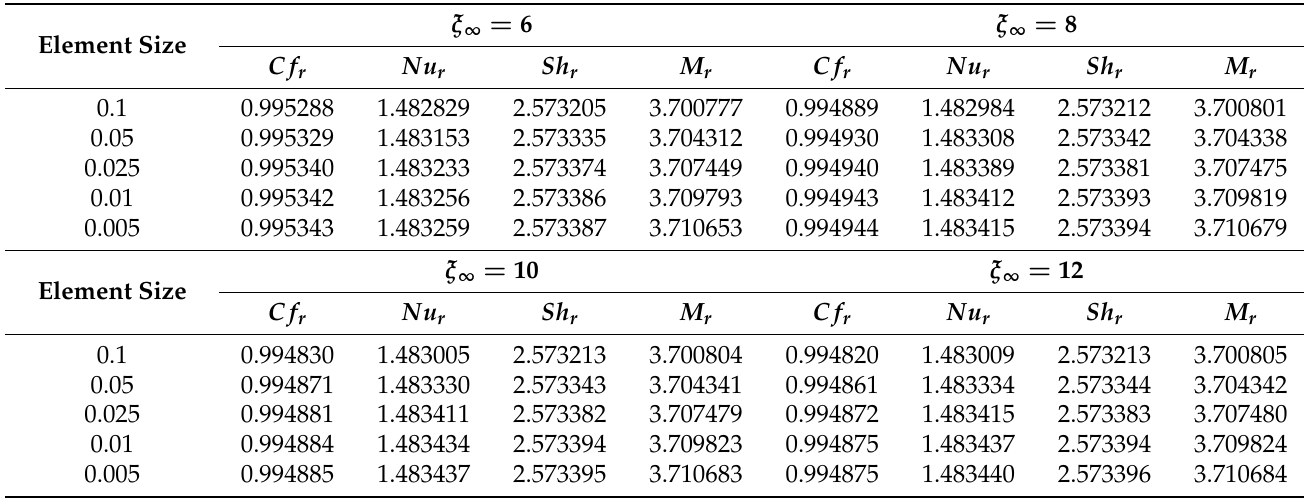
Table 3. Mesh independency test with quadratic shape function ( m = 3) and boundary layer thickness ( ξ ∞ ).